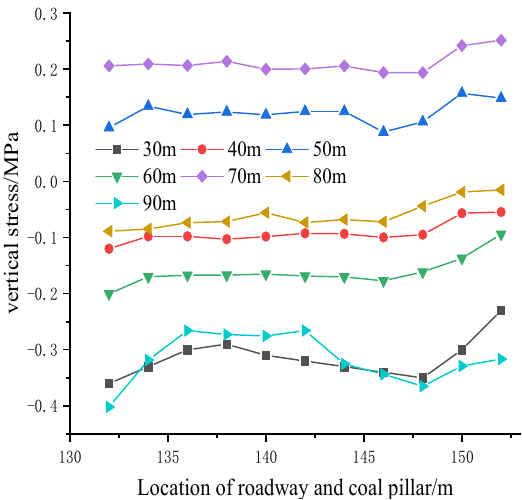
Figure 14. Influence of excavation disturbance on upper coal seam.